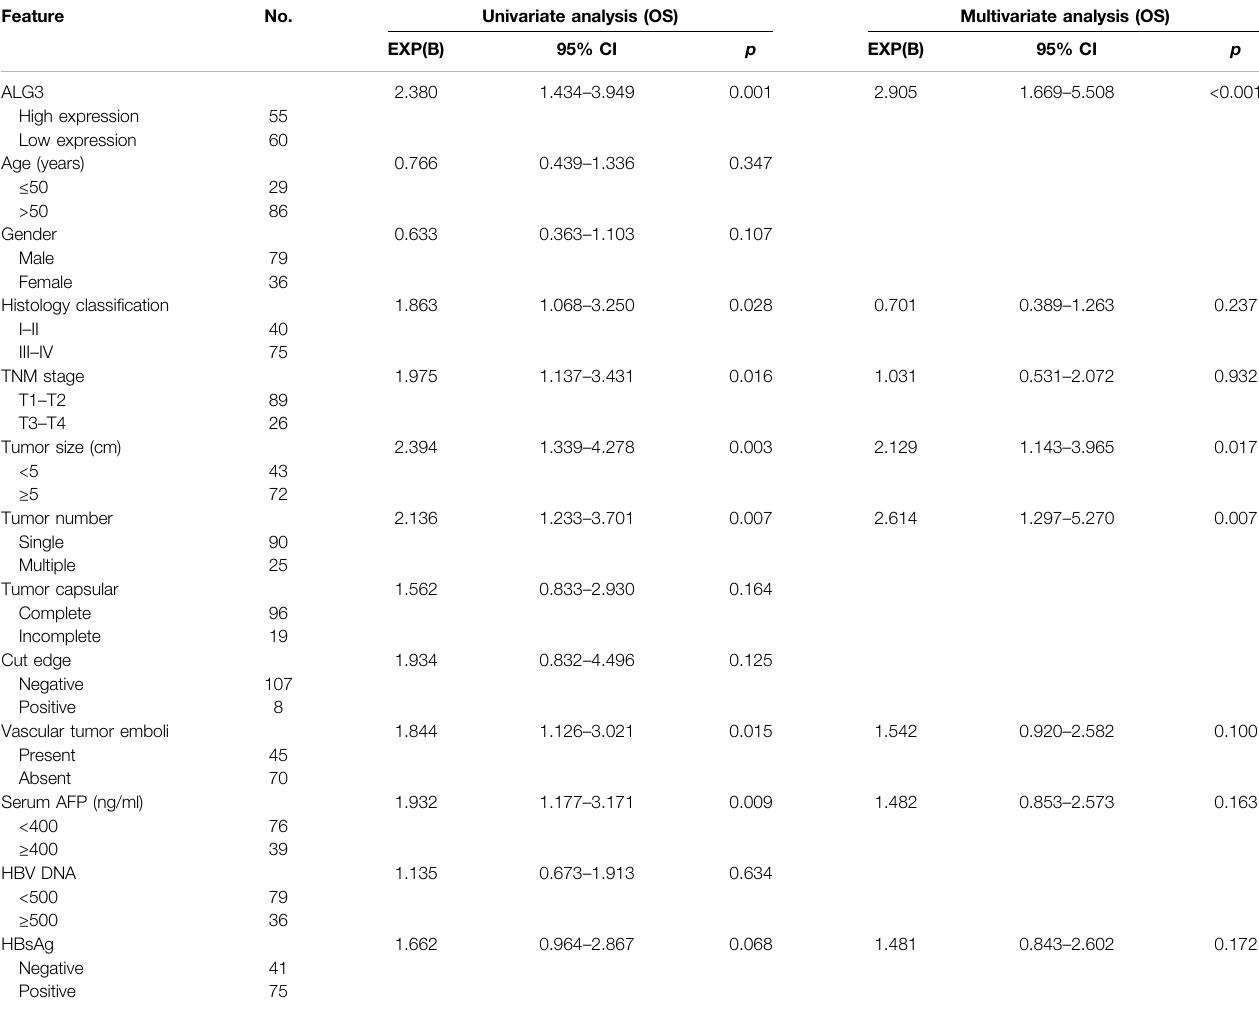
TABLE 2 | Univariate and multivariate analysis of overall survival between the ALG3 expression and other clinicopathologic features.